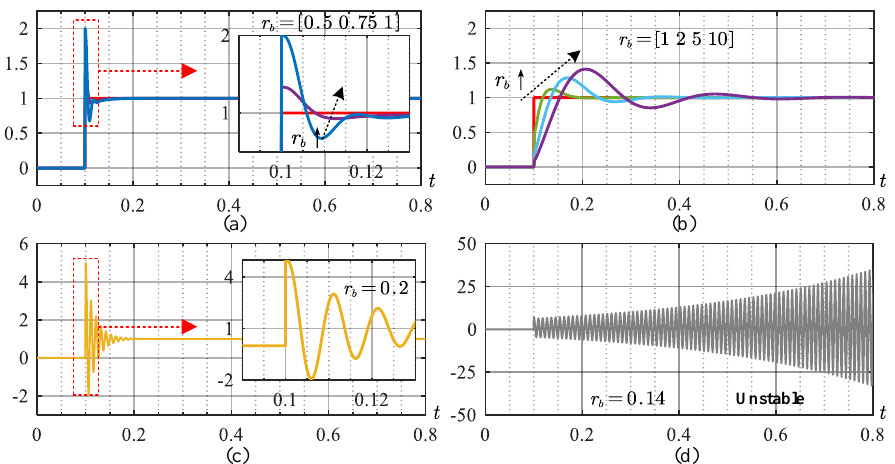
  G s r . Figure 6. Step response of G ω ( s ) under different r b . ( a ) r b = [ 0.5 0.75 1 ] ; ( b ) r b = [ 1 2 5 10 ] ; ( c ) r b = 0.2; under different b 